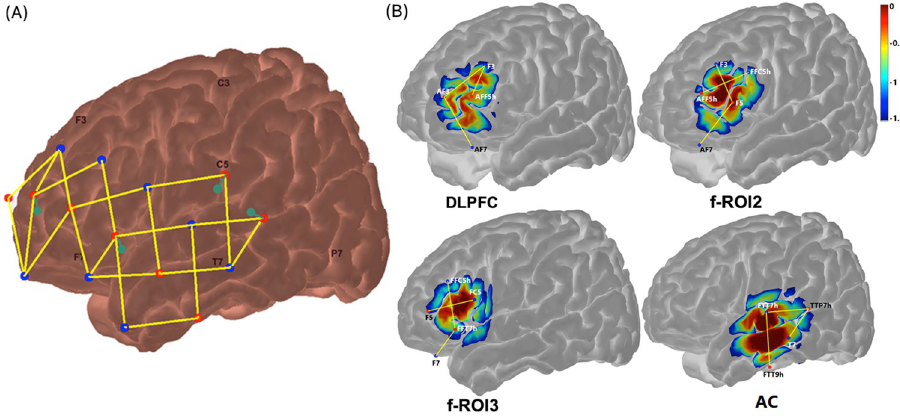
Fig 1. fNIRS montage and a priori regions of interest (ROIs). The fNIRS montage was symmetric between hemispheres; panel (A) plots the connection of light sources (red, n = 8) and detectors (blue, n = 8), and channels (yellow lines) on the left hemisphere. The green dots denote detectors that provide 8-mm channels, with 4 on each side. Panel (B) shows channels comprising the three subregions within the left lateral prefrontal cortex (LPFC) and the left auditory cortex (AC). The three regions were the dorsolateral prefrontal cortex (DLPFC), and two adjacent regions of interest, i.e., f-ROI2 and f-ROI3. The colors are the sensitivity profiles, in log10 mm-1 units, generated from AtlasViewer